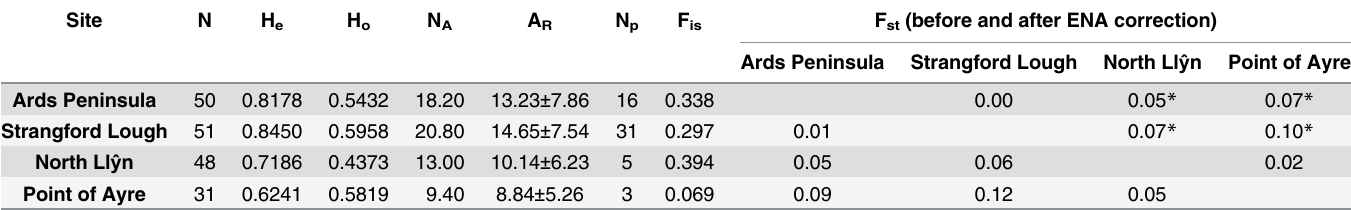
Table 3. Genetic Diversity Parameters inferred from microsatellites.